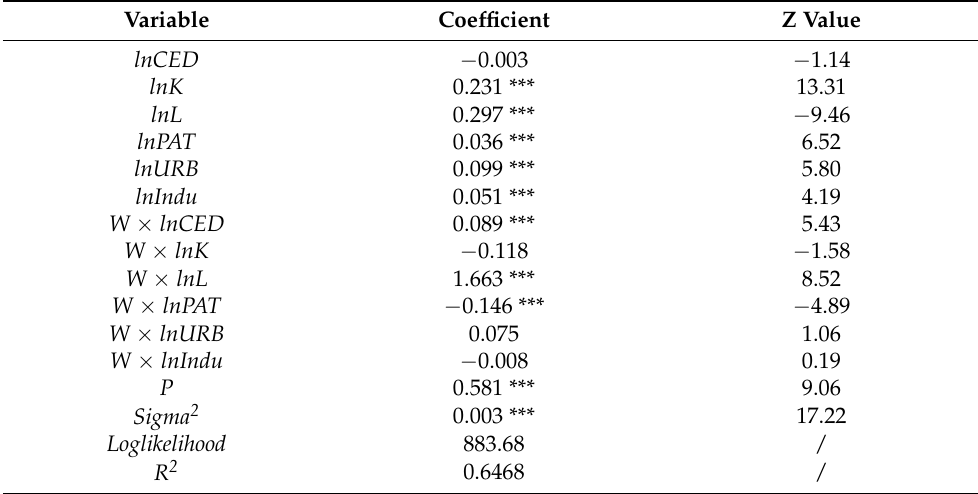
Table 5. Spatial regression results of the time–space double fixed model of